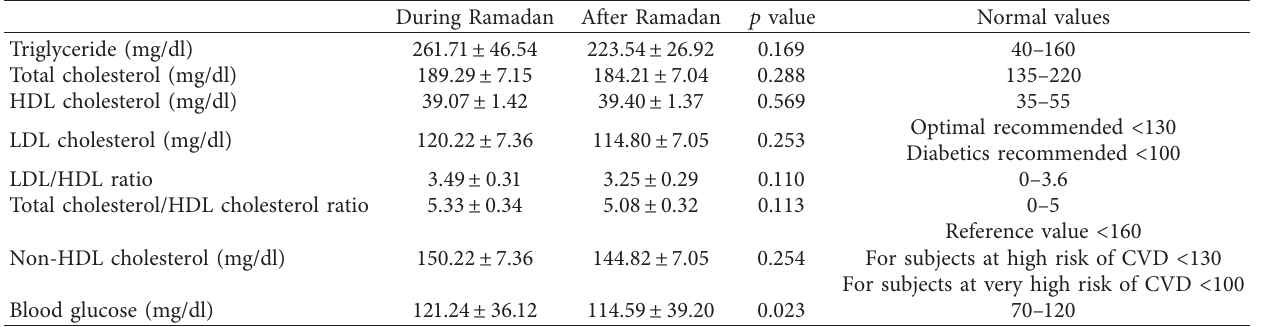
Table 3: Lipid profile and glycemic levels among participants during and after